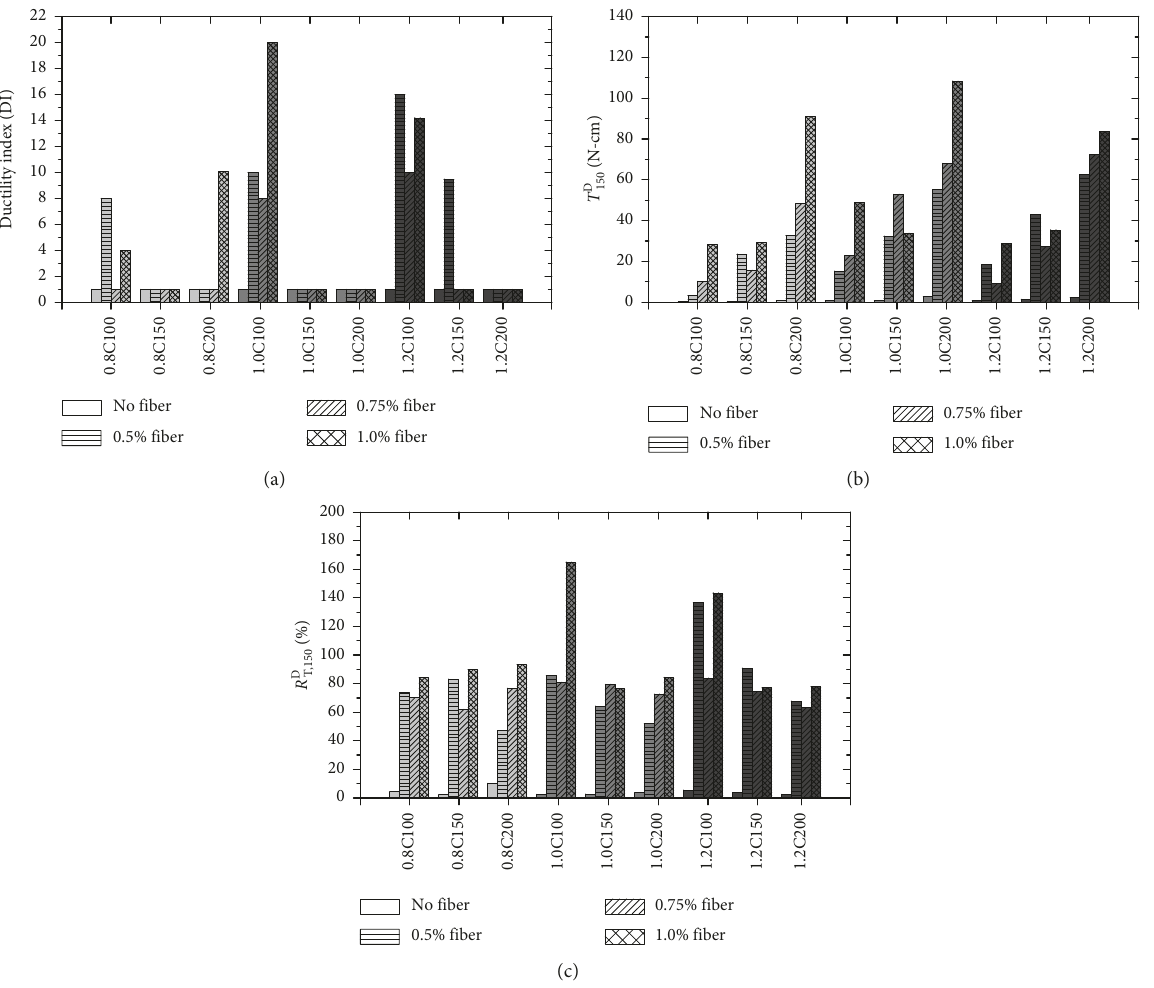
Figure 7: Effect of fiber content on (a) DI, (b) T D